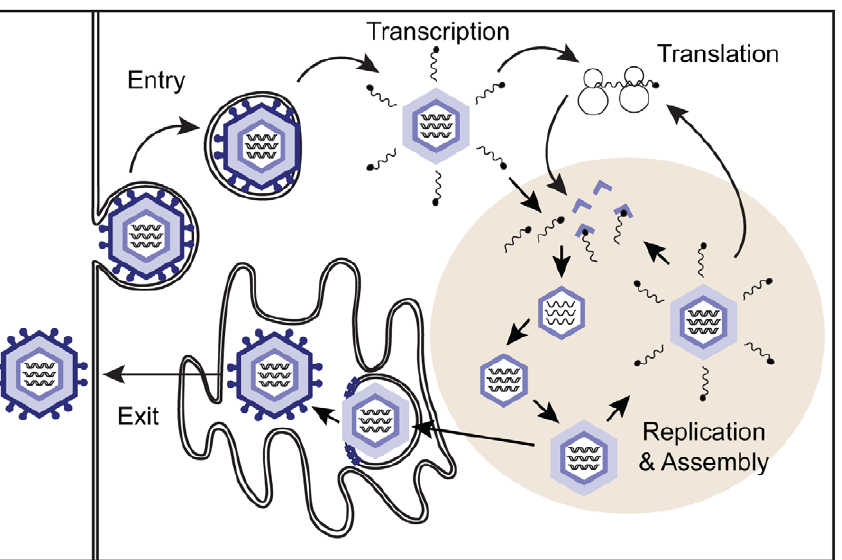
Figure 1. Overview of the rotavirus replication cycle. During entry into the cell, the outermost protein layer of the triple-layered virion is lost. Polymerase complexes in the core of the resultant double-layered particle produce viral mRNAs that are capped but lack poly(A) tails. Viral proteins and RNAs accumulate in protected sites of the cytoplasm called viroplasms where nascent particle assembly takes place. Interaction of newly formed polymerase complexes with the core capsid protein triggers genome replication, which is followed by addition of the intermediate protein layer of the virion. Double-layered particles bud into the endoplasmic reticulum, acquiring their outer capsid. After release through lysis or trafficking, the attachment spike must be cleaved by trypsin-like proteases in the intestinal lumen to activate the virus for subsequent infection.